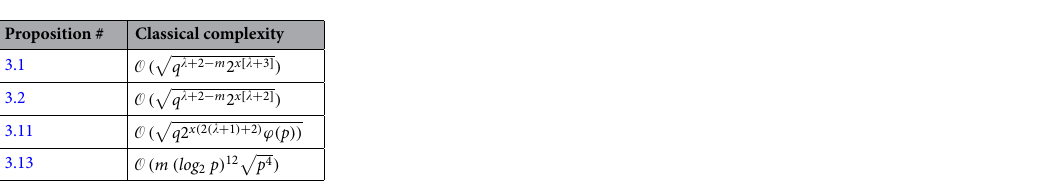
Table 2. Quantum complexity of the best attacks we have discovered on the Optimized MPPK/DS scheme to this date.